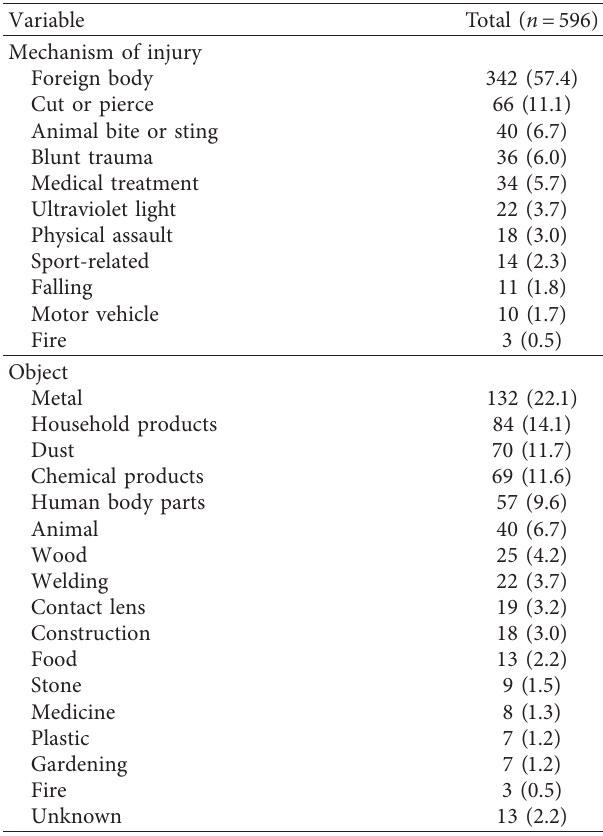
Table 3: Characteristics of traumatic eye patients.